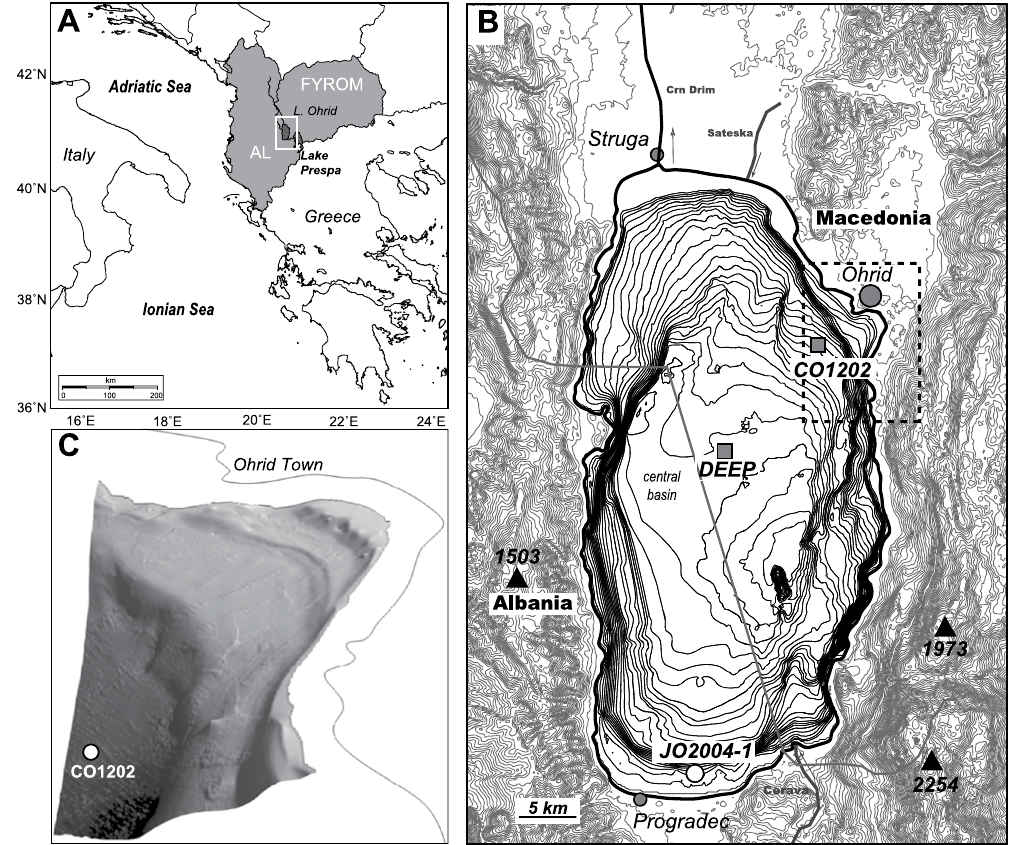
Figure 1. Location of Lake Ohrid in the Western Balkans ( A ), morphology and bathymetry of the Ohrid Basin and position of study site Co1202, the ICDP coring site DEEP and core JO2004-1 ( B ) and high-resolution bathymetry of the terrace system in Ohrid Bay ( C ). Plates A-C were generated using Generic Mapping Tools (GMT 5.2.1; http://gmt.soest.hawaii.edu), Global Mapper (http://www.bluemarblegeo.com) and Fledermaus 7.0 (http://www.qps.nl),